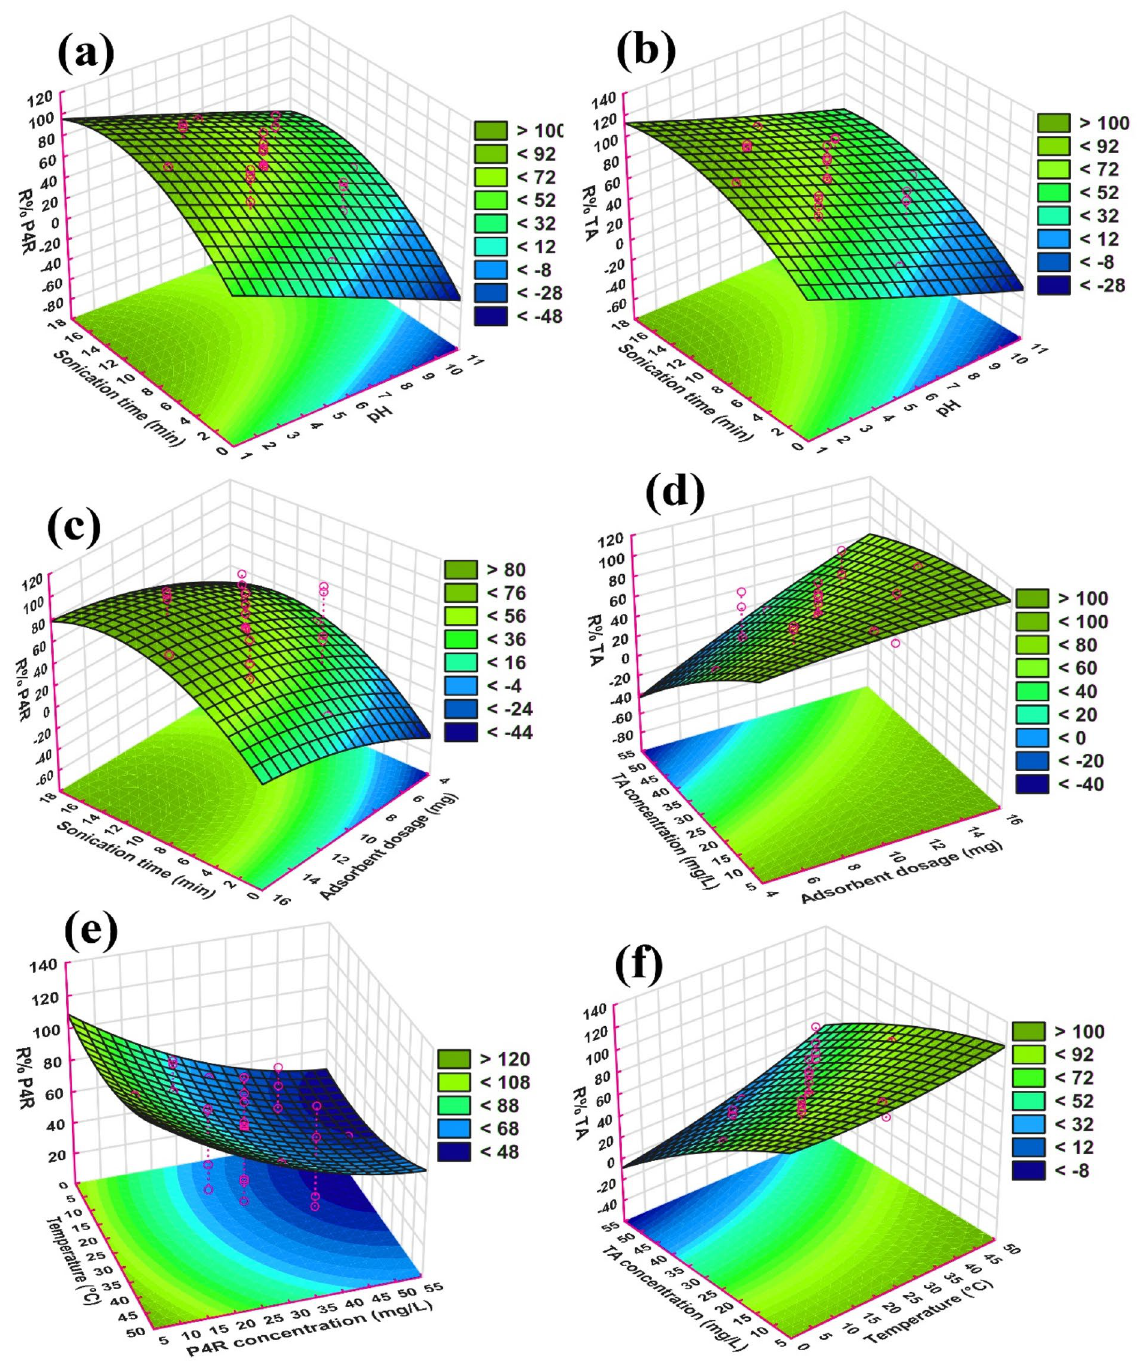
time/concentration, and ( e , f ) temperature-dye